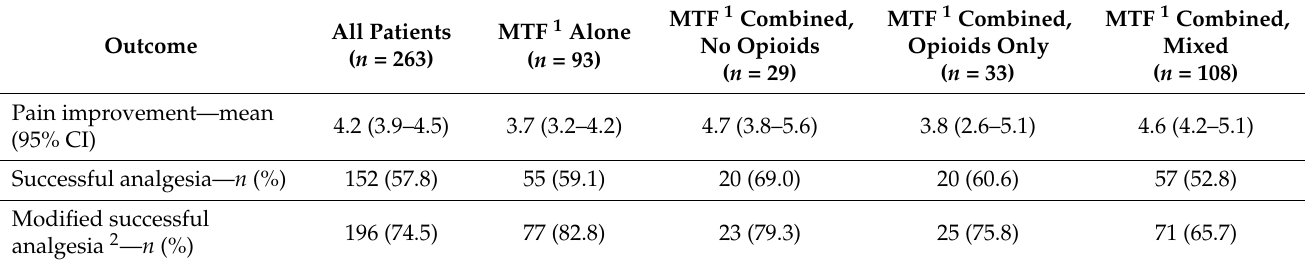
Table 2. Pain outcomes.